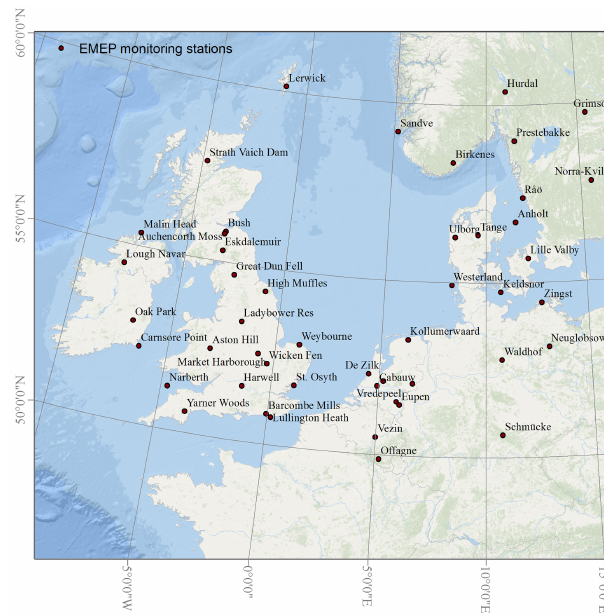
Figure 6. Locations of the EMEP measurement stations used for model